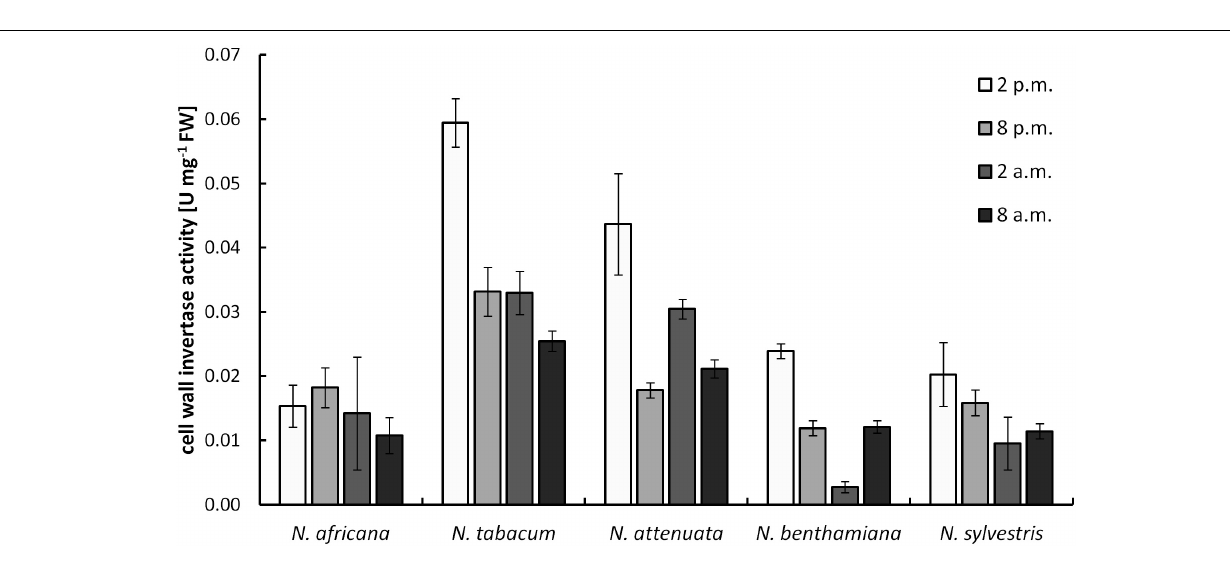
FIGURE 5 | Cell wall invertase (CW-INV) activity in nectary tissue. Mean values from all measurements taken at one time point ( n = 3) and the respective SD were